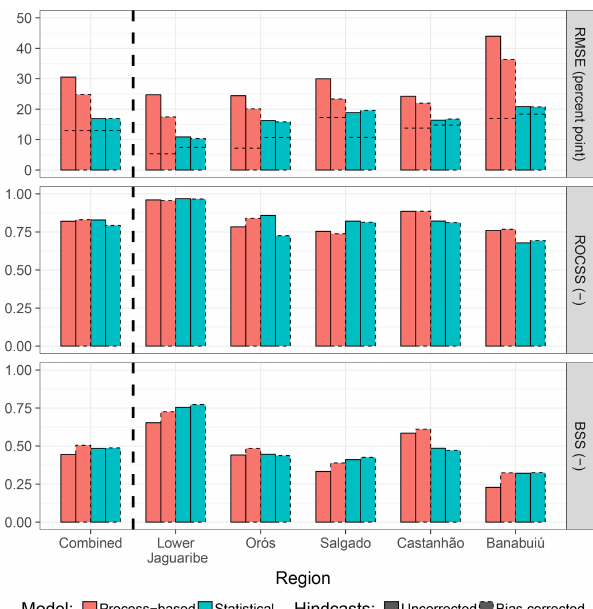
Figure 13. As Fig. 4 but driving hindcasts with additional bias cor- rection of precipitation on the monthly scale (dotted